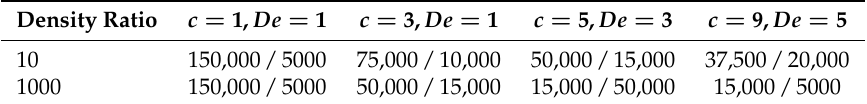
Table 1. Each entry in the table shows N d / N ens for increasing viscoelastic effects and different density ratios. N d is the number of dumbbells per ensemble and N ens the number of ensembles scattered in the